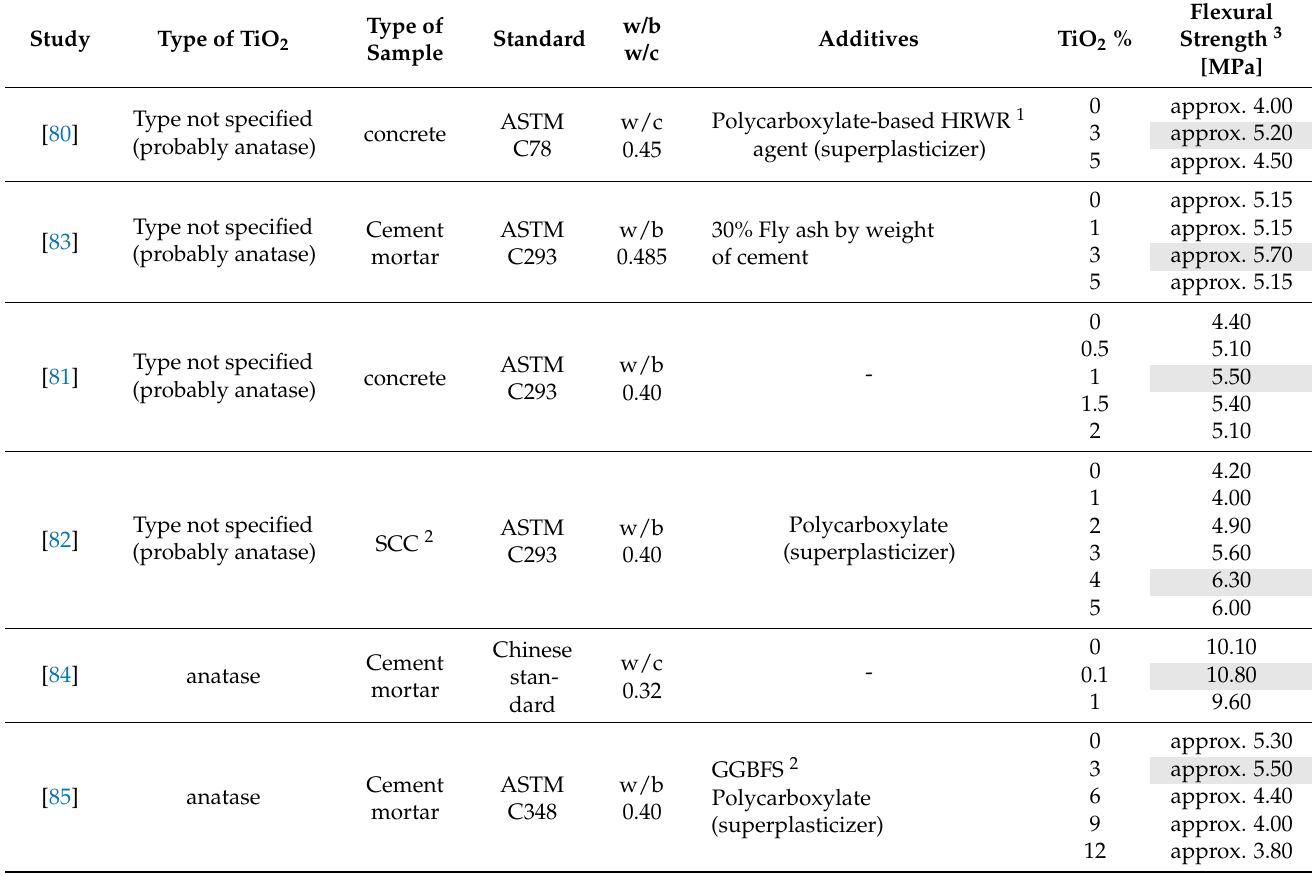
Table 7. Flexural strength values mortar/concrete specimens modified with TiO 2 nanoparticles, at room